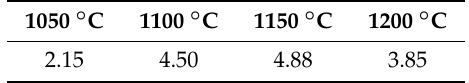
Table 4. Root mean square error (RMSE)